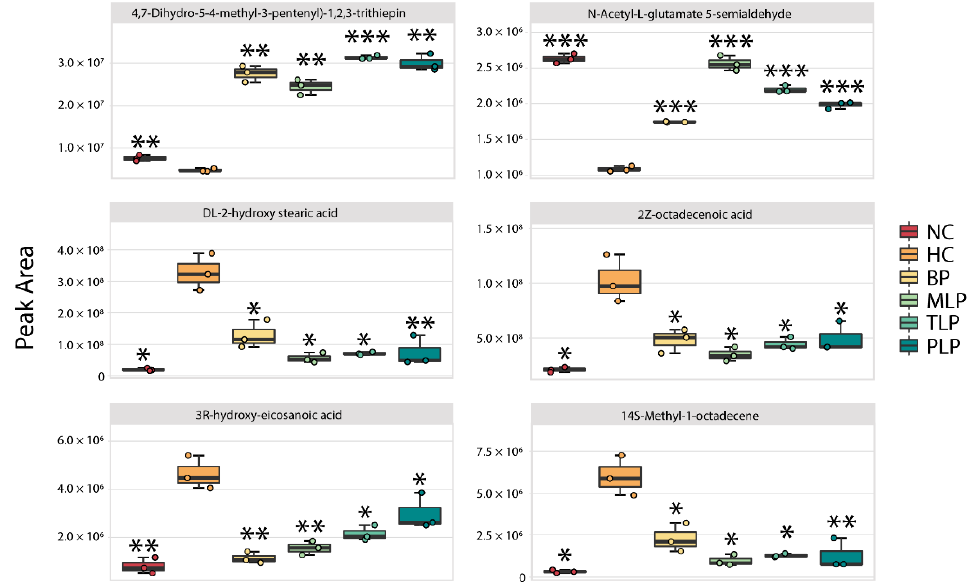
Figure 4. Changes in the content of six core metabolites in different groups after 48 h of fermentation in vitro. Differences from the HC group were assessed using Student’s t test and are denoted as follows: * p < 0.05, ** p < 0.01, *** p < 0.001. NC: the feces of the healthy population was inoculated in FAM; HC: the feces of hyperlipidemia people was inoculated in FAM; BP, MLP, TLP, PLP: the feces of hyperlipidemia people were inoculated in FAMs with 0.5% of BP, MLP, TLP, and PLP. All experiments were repeated triply (n = 3).